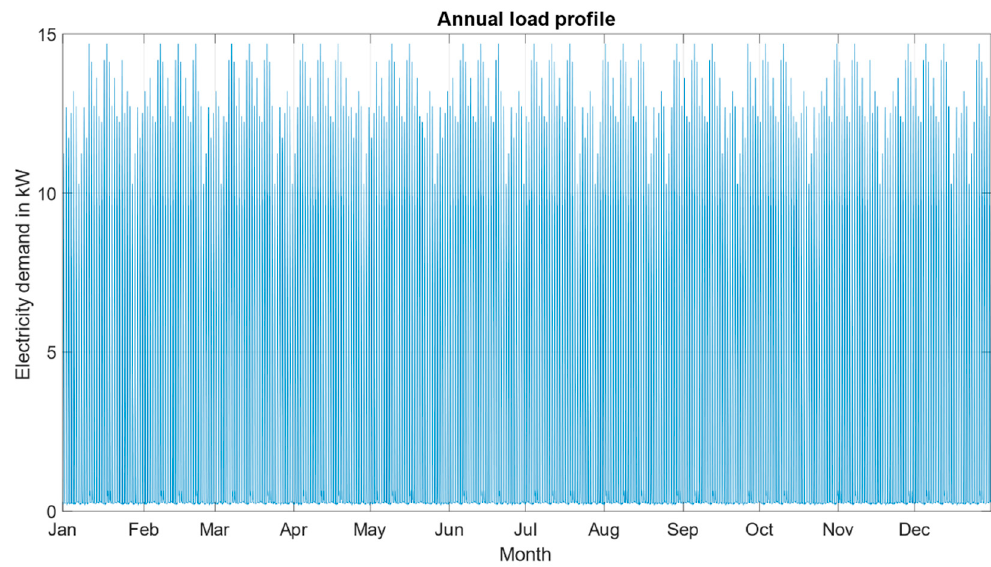
Figure 19 . WeTu Hub annual hourly electricity demand profile including e-bikes. Figure 19. WeTu Hub annual hourly electricity demand profile including